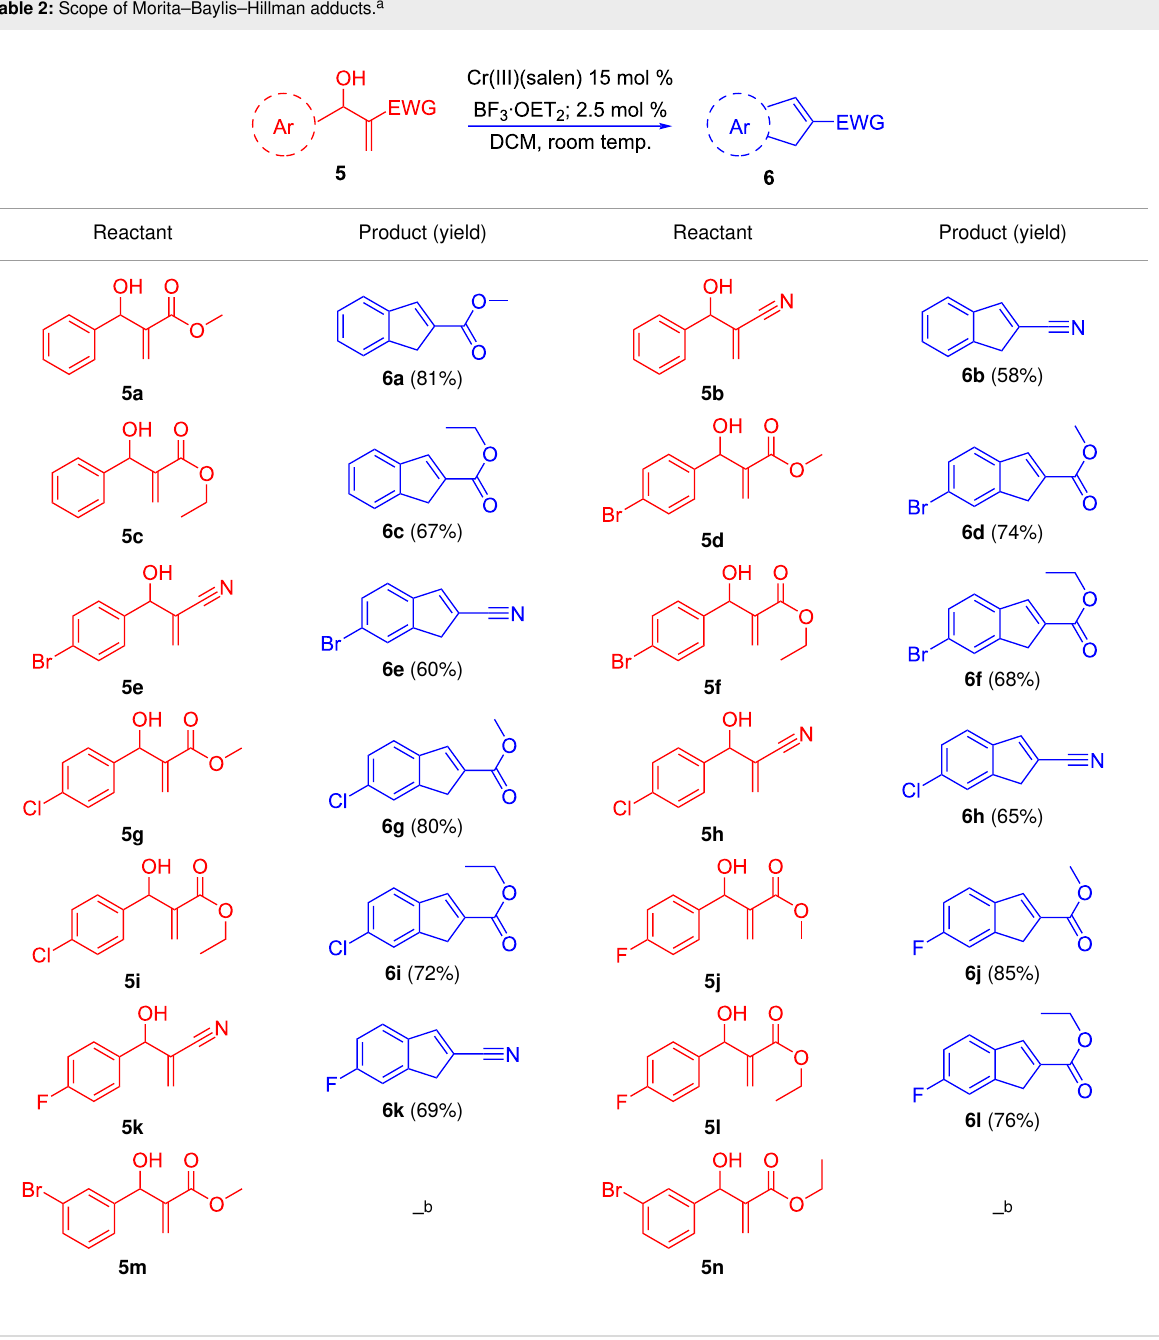
Table 2: Scope of Morita–Baylis–Hillman adducts.